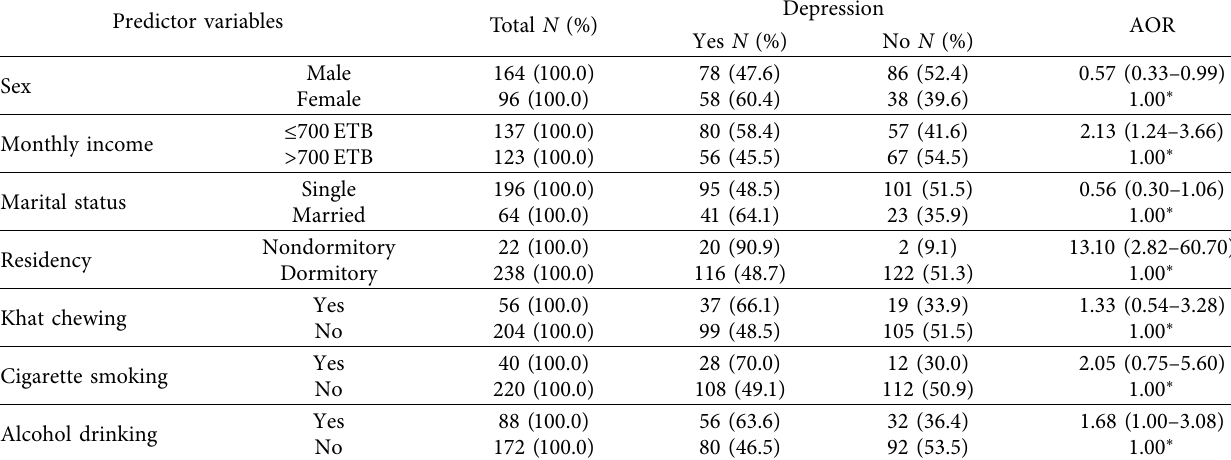
Table 8: Multiple logistic regressions of depression and predictor variables, N � 260, AU, January